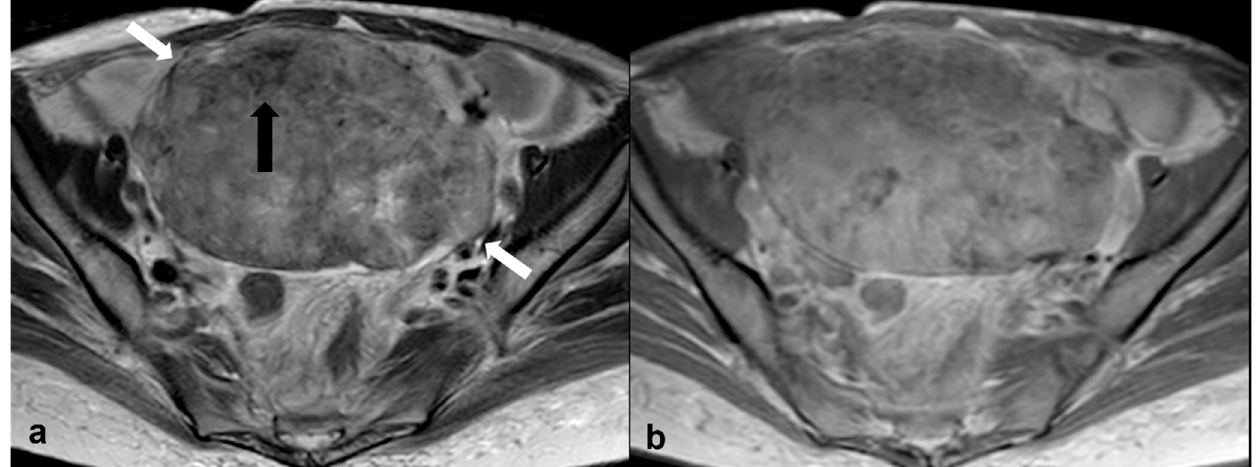
Figure 13 . Malignant Brenner tumor. Axial T2 weighted image (a) shows a large, predominantly solid mass of moderately high signal intensity (white arrows) with areas of lower T2 signal (black arrow), occupying the pelvis. Axial T1 weighted CE image ( b ) shows mild, heterogeneous enhancement of the mass.